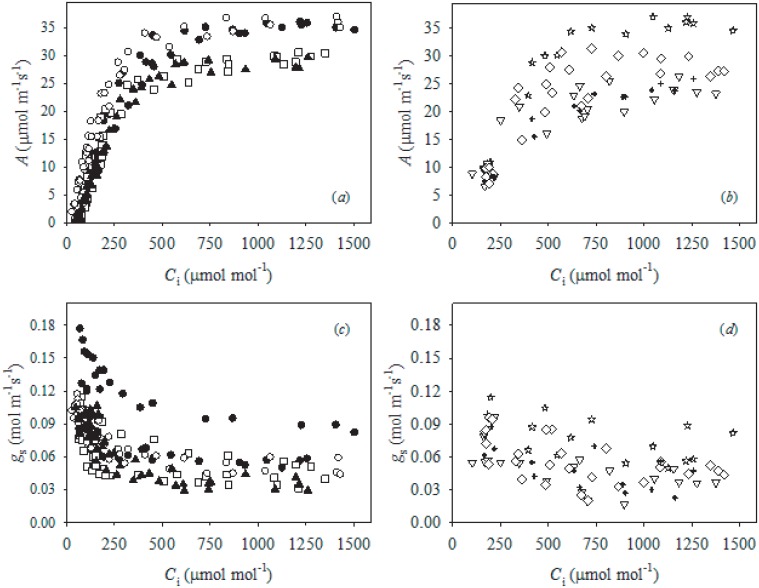
The relationship between (a, b) photosynthesis (A) and intercellular [CO2] (Ci), and (c, d) stomatal conductance (gs) and Ci measured after exposing olive (var. ‘Chetoui’) leaves to a [CO2] of ~50 ppm for approximately 60 minutes to force stomatal opening [56] during the morning (between 900 and 1100 h), with relative humidity ranging between 45 and 55% and leaf temperature of 25°C(a, c), and during the early afternoon (between 1330 and 1430 h) with relative humidity ranging between 30 and 35% and leaf temperature of 30°C (b, d).The measurements were made on three to four plants per irrigation treatment in saturating PPFD (1400 μmol m-2s-1) in the control (●,☆), PRD50(□,▿), PRD100 (○,◇) and rain-fed (▲,✚) treatments during October 2007.